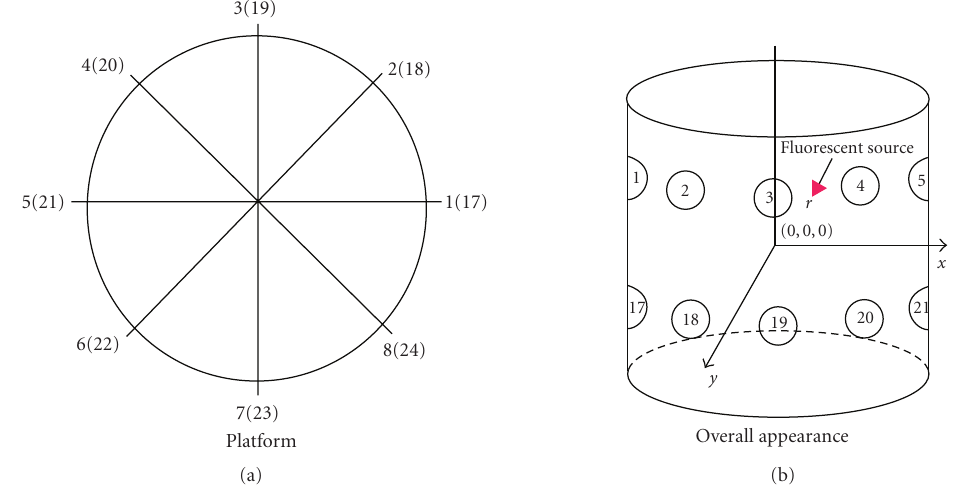
Figure 2: Cylinder phantom: platform and overall